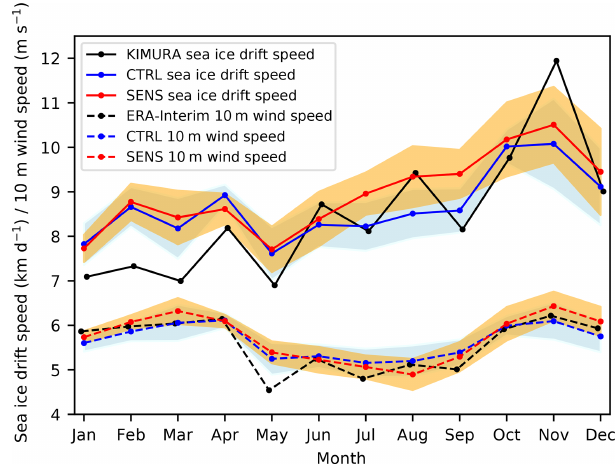
Figure 12. Mean annual cycle of sea ice drift speed (kmd − 1 , solid lines) and 10m wind speed (ms − 1 , dashed lines), based on the CTRL experiment (ensemble mean; blue lines), SENS exper- iment (ensemble mean; red lines) and the observation/reanalysis (KIMURA ice drift, ERA-I wind; black lines) for 2007 over the study domain (indicated in Fig. 1). The across-ensemble scatters (standard deviation) of the simulations are included as shaded area (light blue for CTRL, orange for